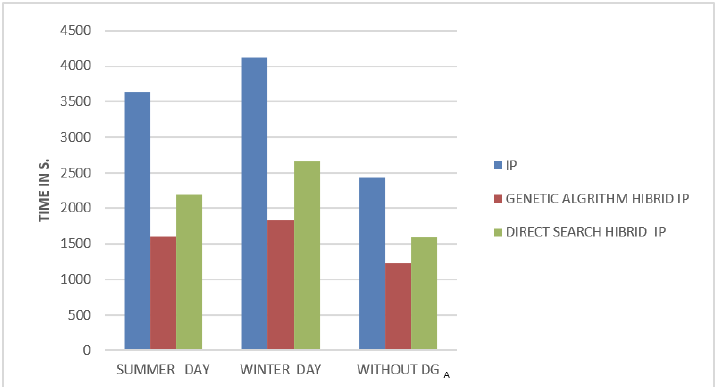
Figure 16. Run times for the proposed methods.